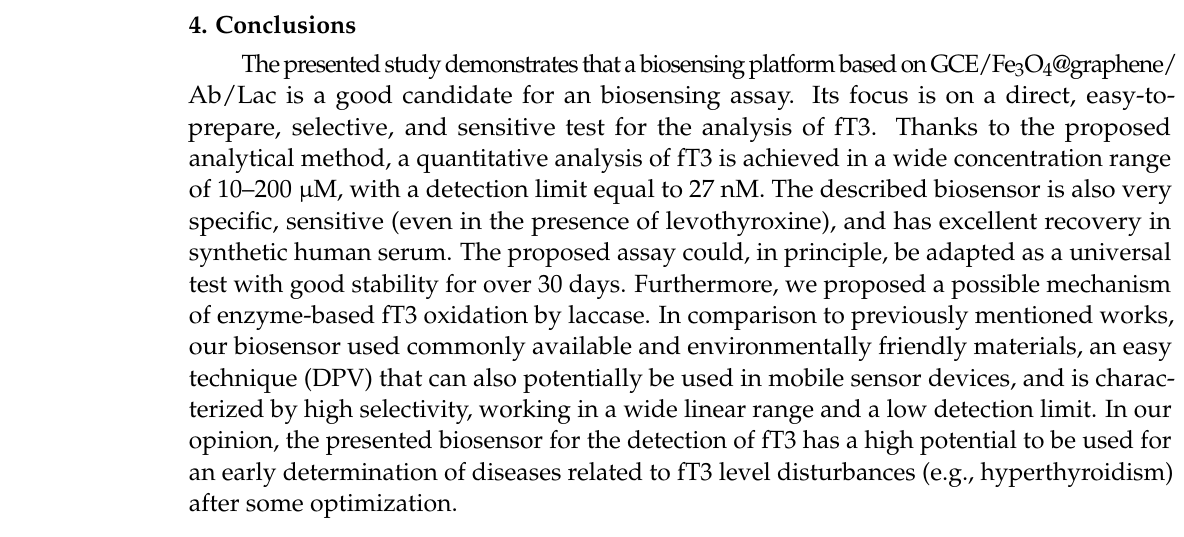
Table 1. Results obtained for the detection of fT3 in synthetic human serum.